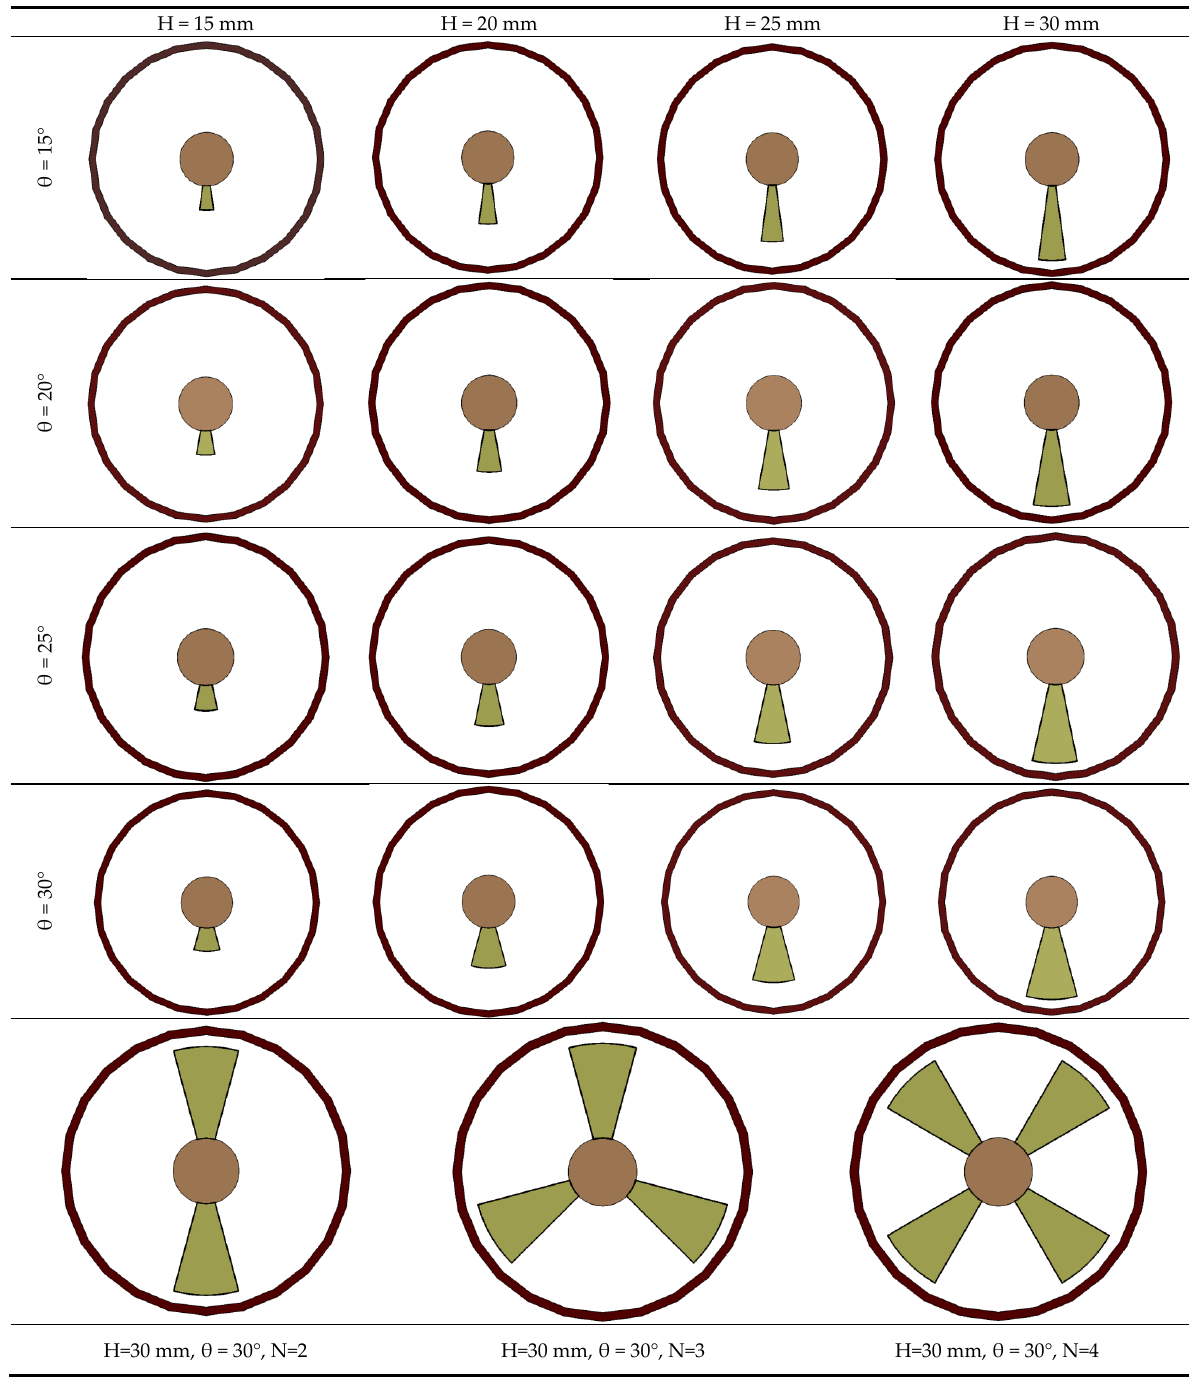
Figure 4. Various configurations of the examined straight conical strips in the current study.